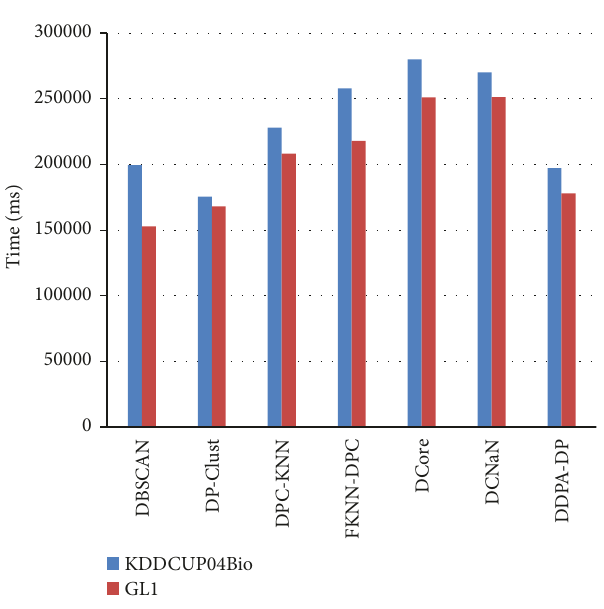
Figure 23: The runtimes in large data